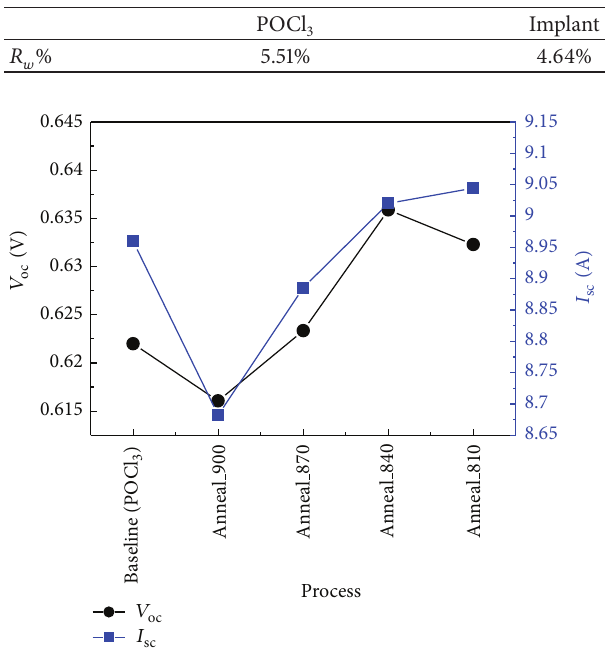
Table 5: Comparison of 𝑅 𝑤 % between POCl tation after ARC deposition.